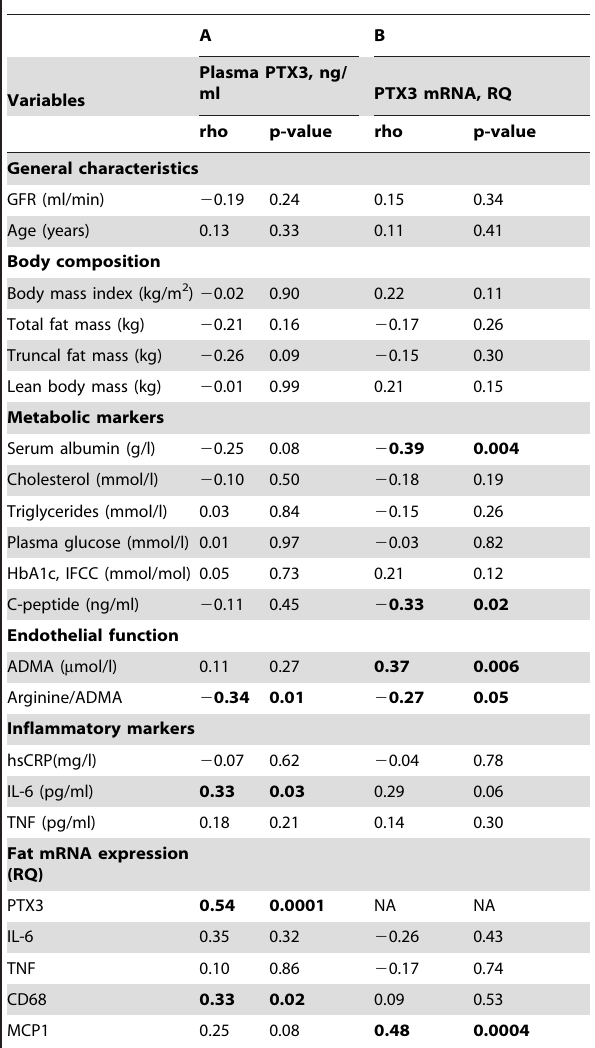
Table 2. Univariate Spearman correlations with circulating PTX3 (A) or adipose tissue PTX3 mRNA (B) and clinical/ biochemical variables in 56 patients with CKD stage 5.